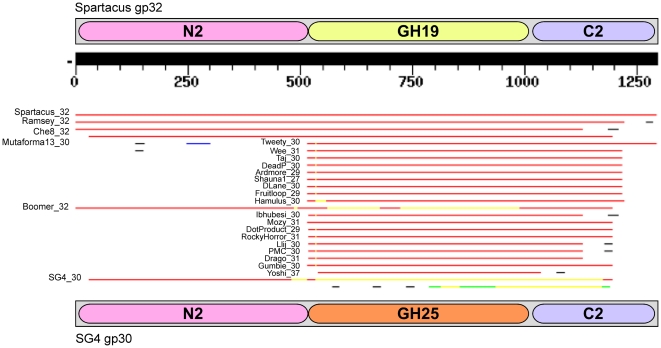
Domain swap between Spartacus gp32 and SG4 gp30.The locations of the three domains in the two proteins are shown, flanking the BLASTP output generating by a search using Spartacus gp32 as the query.